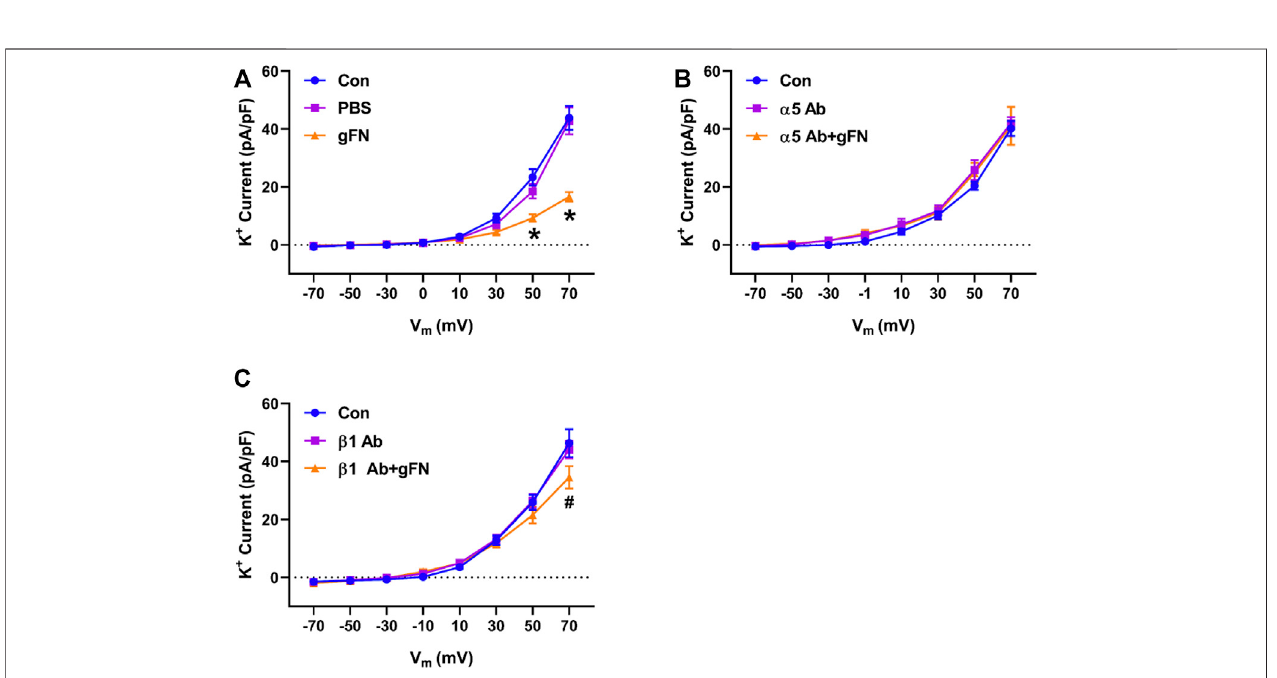
FIGURE 6 | A function-blocking antibody versus either integrin α 5 or β 1 subunits blocks the gFN effect on whole cell K + currents of cerebral VSMCs. Panel (A) , current — voltage relationship under control/buffer (PBS) conditions. Panel (B) , current — voltage relationships in the presence of α 5 antibody (Ab) alone and α 5 antibody plus gFN. Panel (C) , current-voltage relations in the presence of β 1 antibody alone and β 1 antibody plus gFN; n = 12 cells in each group. Results are shown as mean ± SEM. * p < 0.05 control and PBS vs. gFN; # p < 0.05 control and β 1 Ab vs. β 1 Ab + gFN.